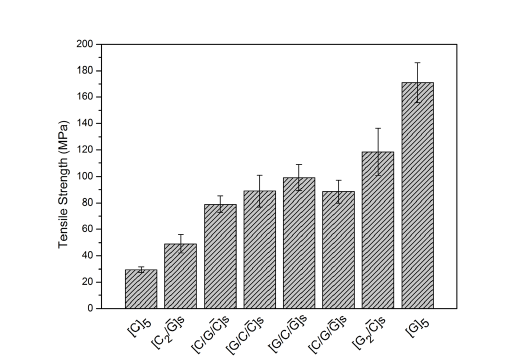
Figure 4. Flexural strength of the studied laminates.